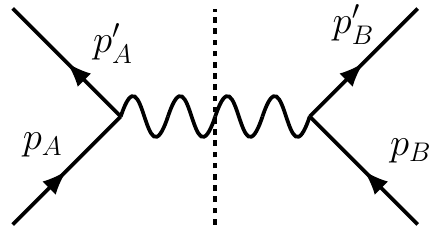
Figure 3 . 2 2 scattering of black holes, →